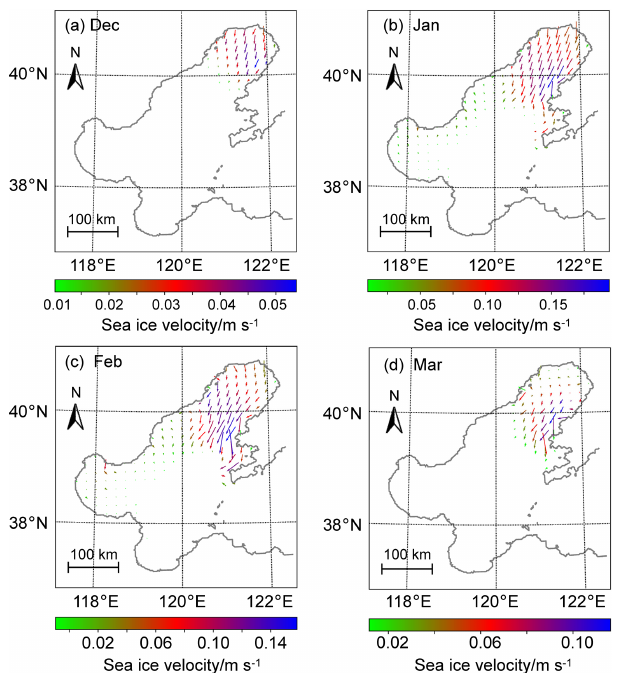
Figure 19. Similar to Fig. 16 but for sea ice velocity.